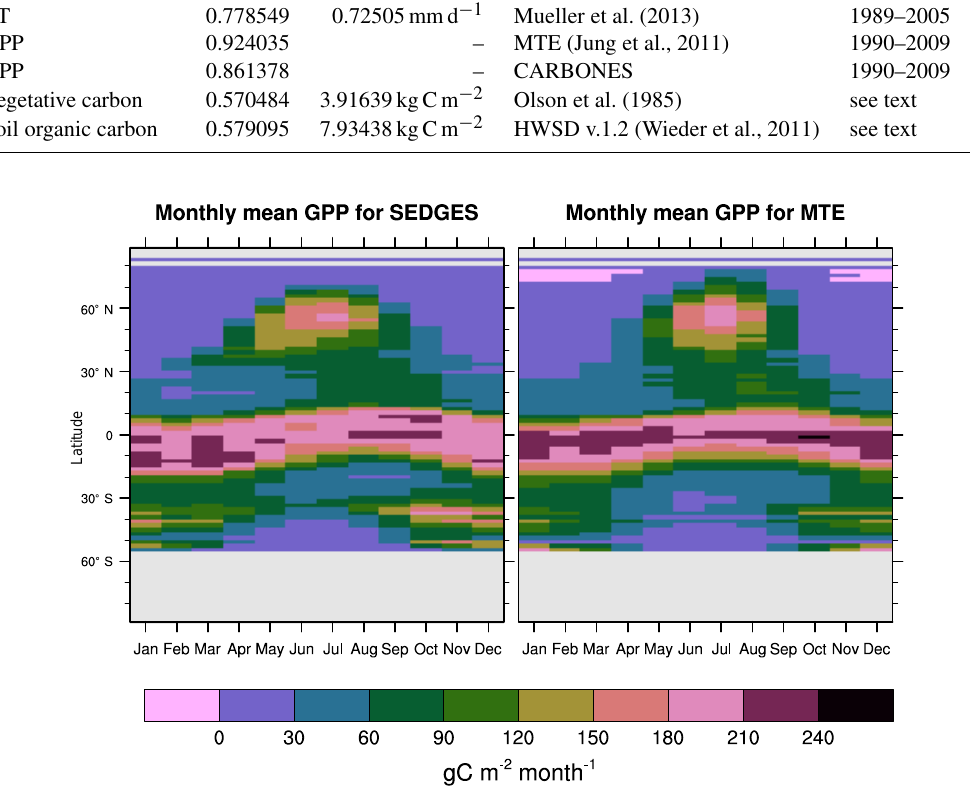
Figure 7. Zonal multiyear monthly means of GPP for SEDGES and the MTE reference dataset for 1982–2010 over non-glaciated land.